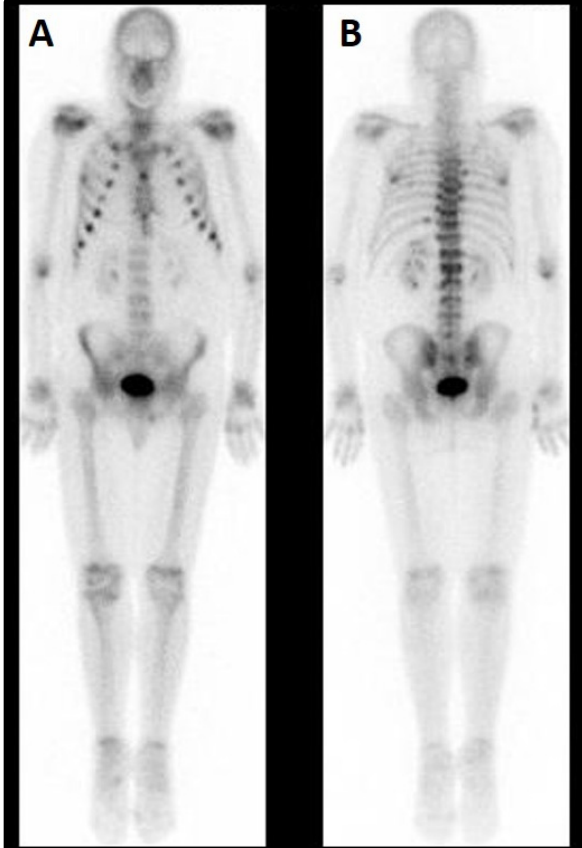
Figure 1. Total body scintigraphy (September 2015). ( A ) Front view. A Marked rosary sign at the chest. ( B ) Back view. Non-homogeneous spinal distribution of the tracer with increased uptake at the dorso-lumbar junction.